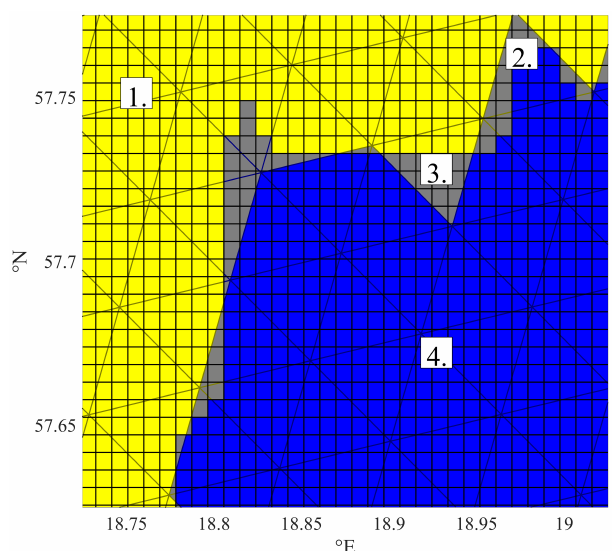
Figure 4. Overlay of the triangular ICON grid and the rectangu- lar GETM grid at the eastern coast of the island of Gotland in the central Baltic Sea; see Fig. 3. The four possible combinations of land/ocean masks are labelled. Grey areas mark different land/ocean masks: ICON ocean and GETM land (case 2); ICON land and GETM ocean (case 3).